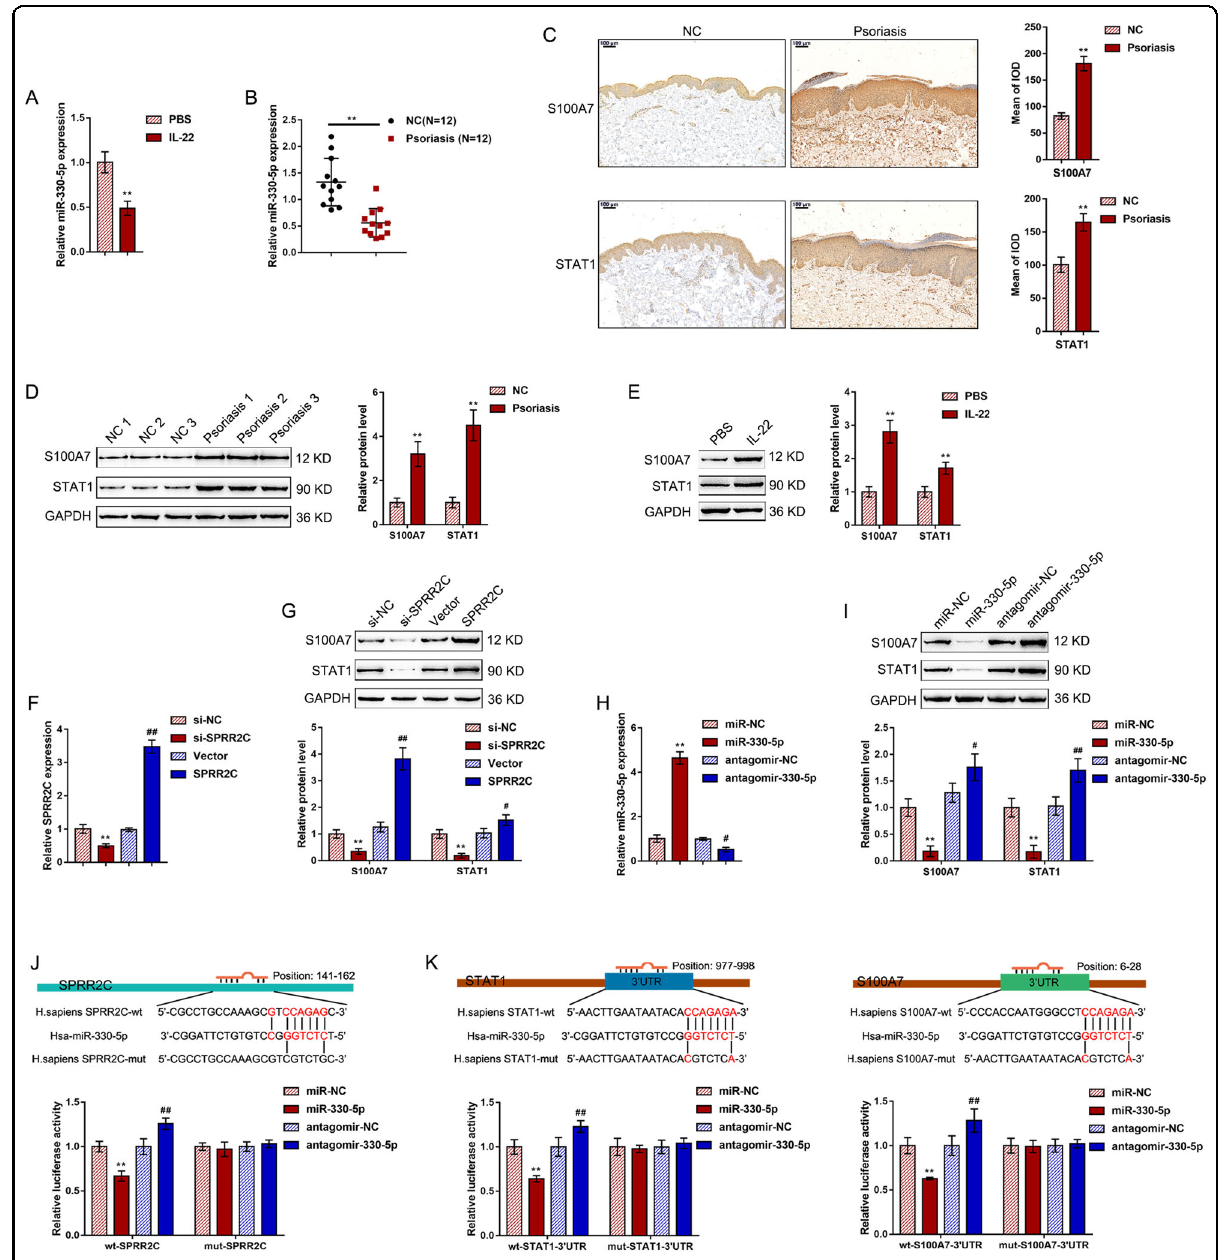
Fig. 4 MiR-330 directly binds to SPRR2C, STAT1, and S100A7. A HaCaT cells were starved in serum-free DMEM for 24 h, treated with IL-22 (100ng/ml) in serum-free DMEM for another 24 h or not treated, and then examined for the expression of miR-330 by real-time PCR. B The expression of miR-330 was determined in 12 psoriatic lesions and 12 nonlesion tissues by real-time PCR. C The protein content and distribution of STAT1 and S100A7 in the psoriatic lesion and nonlesion tissue samples were determined by immunohistochemistry (IHC) staining. D The protein levels of STAT1 and S100A7 in the psoriatic lesion and nonlesion tissue samples were determined by immunoblotting. E HaCaT cells were treated with IL-22 and examined for the protein levels of STAT1 and S100A7 by immunoblotting. F SPRR2C knockdown or overexpression was achieved in HaCaT cells by the transfection of si-SPRR2C or SPRR2C-overexpressing vector; the transfection ef fi ciency was con fi rmed by real-time PCR. G HaCaT cells were transfected with si-SPRR2C or SPRR2C-overexpressing vector and examined for the protein levels of STAT1 and S100A7 by immunoblotting. H MiR-330 overexpression or inhibition was achieved by the transfection of miR-330 or antagomir-330-5p; the transfection ef fi ciency was con fi rmed by real-time PCR. I HaCaT cells were transfected with miR-330 or antagomir-330-5p and examined for the protein levels of STAT1 and S100A7 by immunoblotting. J , K Wild-type and mutant-type SPRR2C, STAT1 3 ′ UTR, and S100A7 3 ′ UTR luciferase reporter vectors were constructed as described in “ Materials and Methods ” . These vectors were cotransfected into 293T cells with miR-330 or antagomir-330-5p, and the luciferase activity was determined. ** P < 0.01, # P < 0.05, ## P < 0.01.